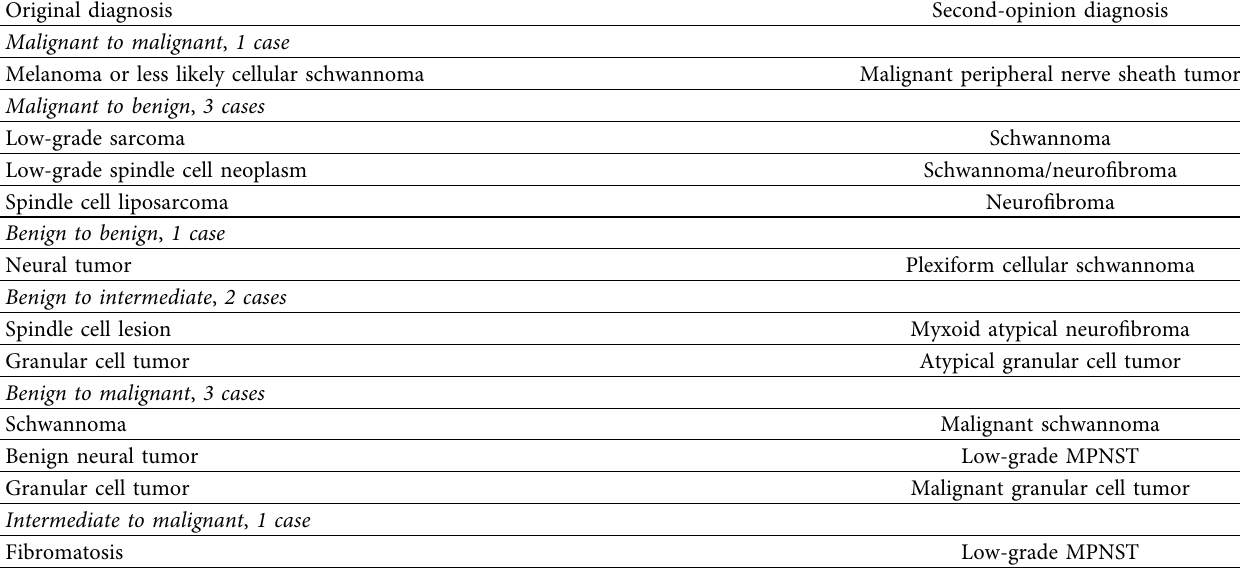
Table 6: Nerve sheath tumors with discrepancy in